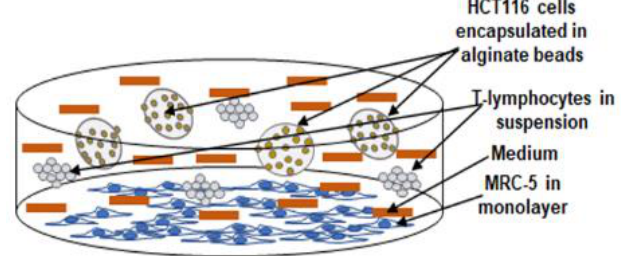
Figure 1. Schematic model showing the experimental setup of multicellular pro-inflammatory TME culture conditions.